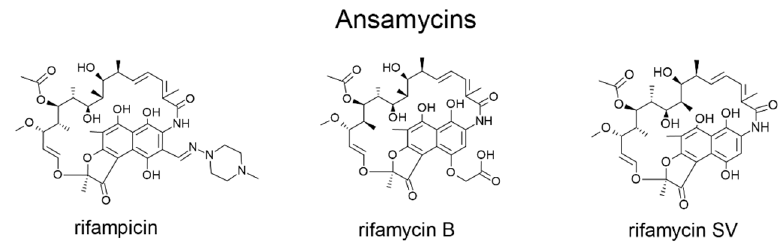
Figure 1. Structure of ansamycins. Table 1. Summary of the physico-chemical properties of macrocyclic antibiotics applied as chiral selectors [13].